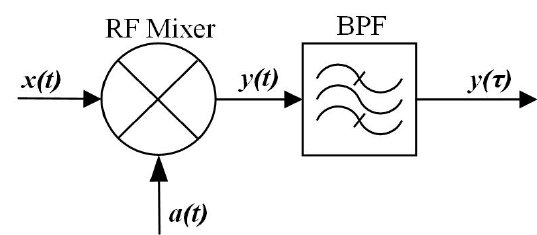
Fig. 1. It’s a linear mathematical model of radio pulse stroboscopic converter: the RF Mixer – radio frequency mixer, the BPF – band pass